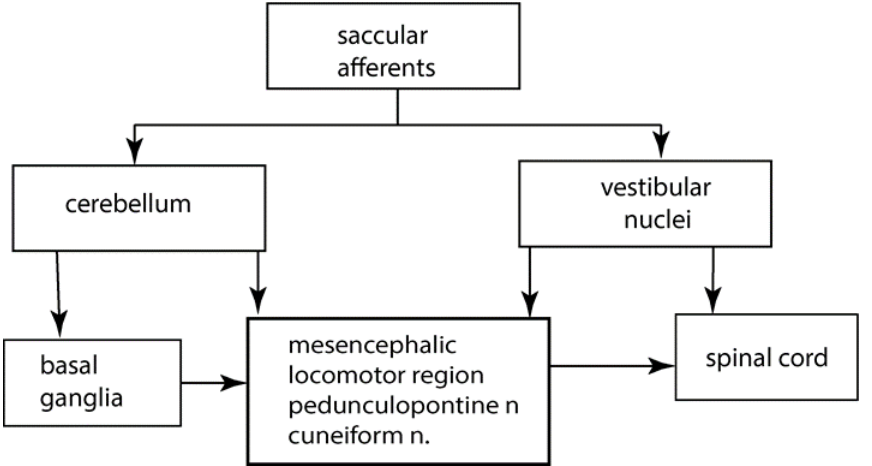
Figure 1. A greatly simplified schematic overview of some of the major structures involved in the control of gait and postural